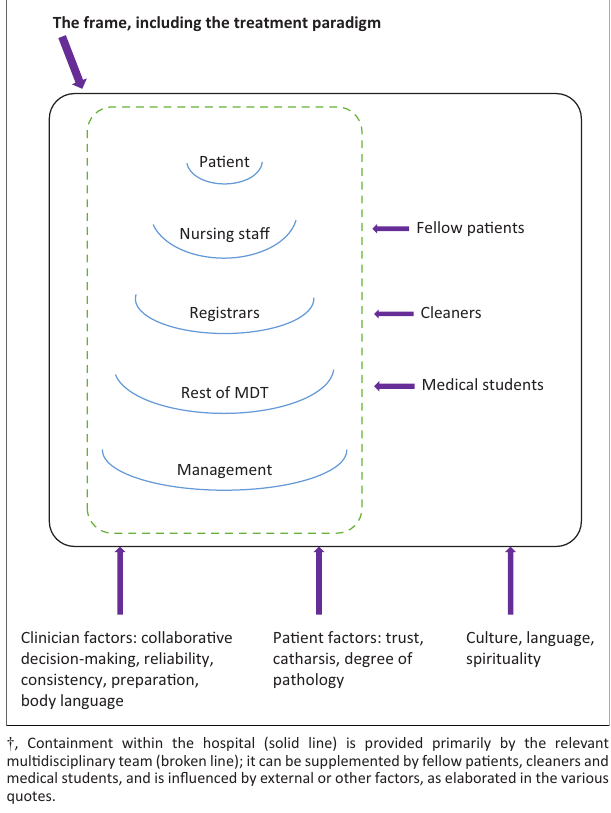
FIGURE 1: A model of containment in a psychiatric training hospital system. †